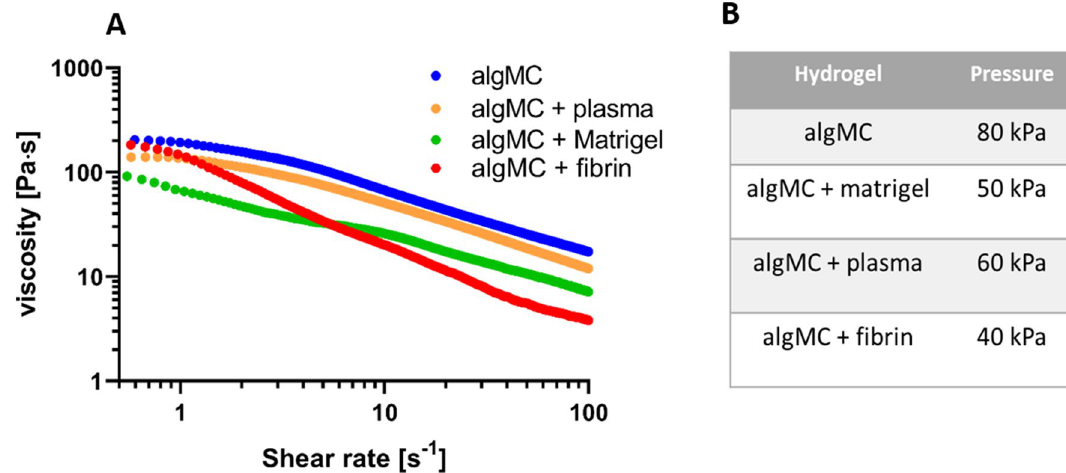
Figure 14. Rheological characterization of functionalized algMC and printing pressure adaptation. ( A ) Representative curves of shear thinning behavior of algMC-based inks at room temperature. ( B ) Printing pressure used for the different bioinks.